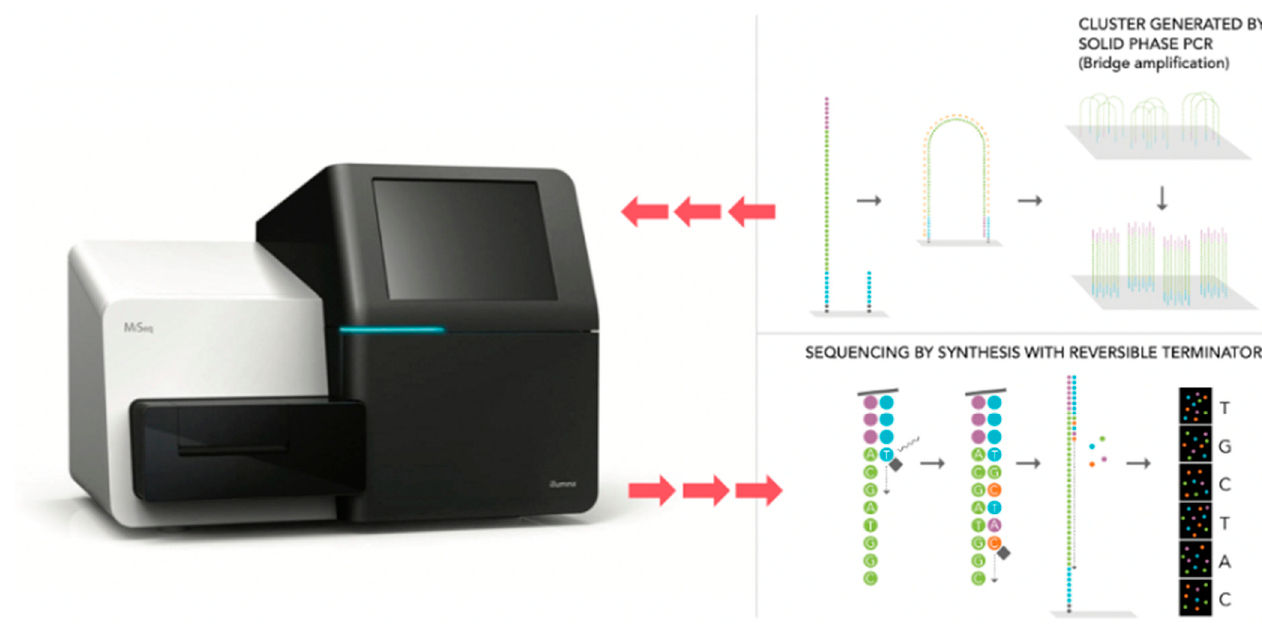
Figure 2. Next Generation Sequencing. Microbial DNA is detected and amplified with bridge PCR for high-throughput sequencings.